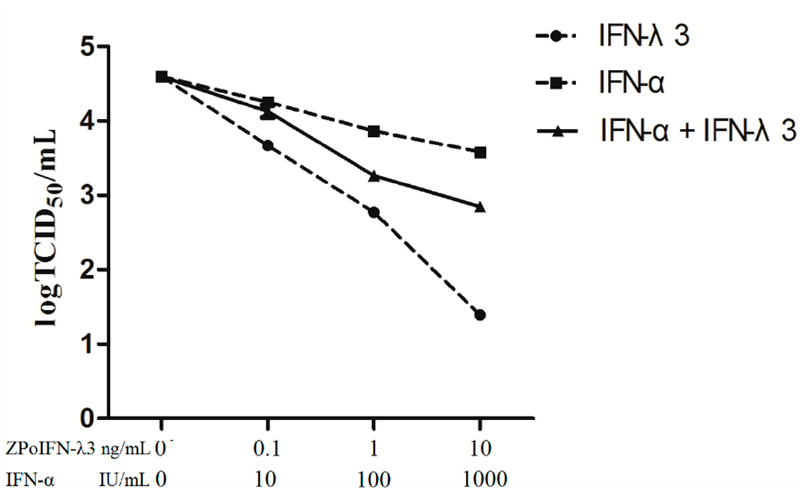
Figure 2. Inhibition of PoRV replication by porcine IFN- α , IFN- λ 3 and IFN- α + IFN- λ 3. IPEC-J2 cells were stimulated with either one IFN alone or in combination with two IFNs for 24 h, and then infected with PoRV at 0.01 MOI for 36 h. The PoRV titer in the supernatant was titrated by TCID 50 . Dotted lines: IFN- α ( ■ ) or IFN- λ 3 ( ● ) used individually; continuous line: IFN- α and IFN- λ 3 ( ▲ ) used in combination. Data were presented as mean ± SEM ( n = 3).